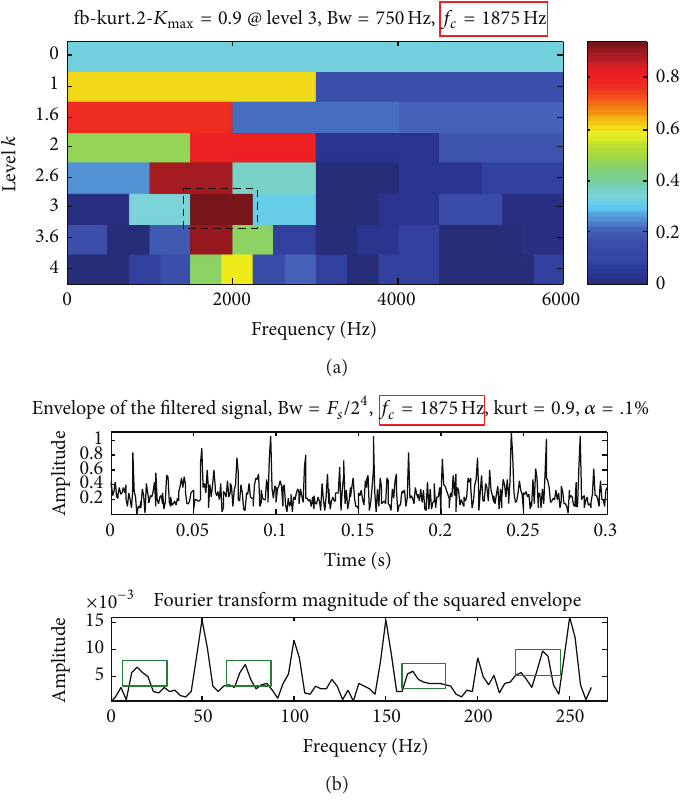
Figure 14: Analyzed results of the simulated signal shown in Figure 8(b) by the fast Kurtogram: (a) Kurtogram of the simulated signal; (b) envelope of the filtered signal and corresponding demodulation spectrum.